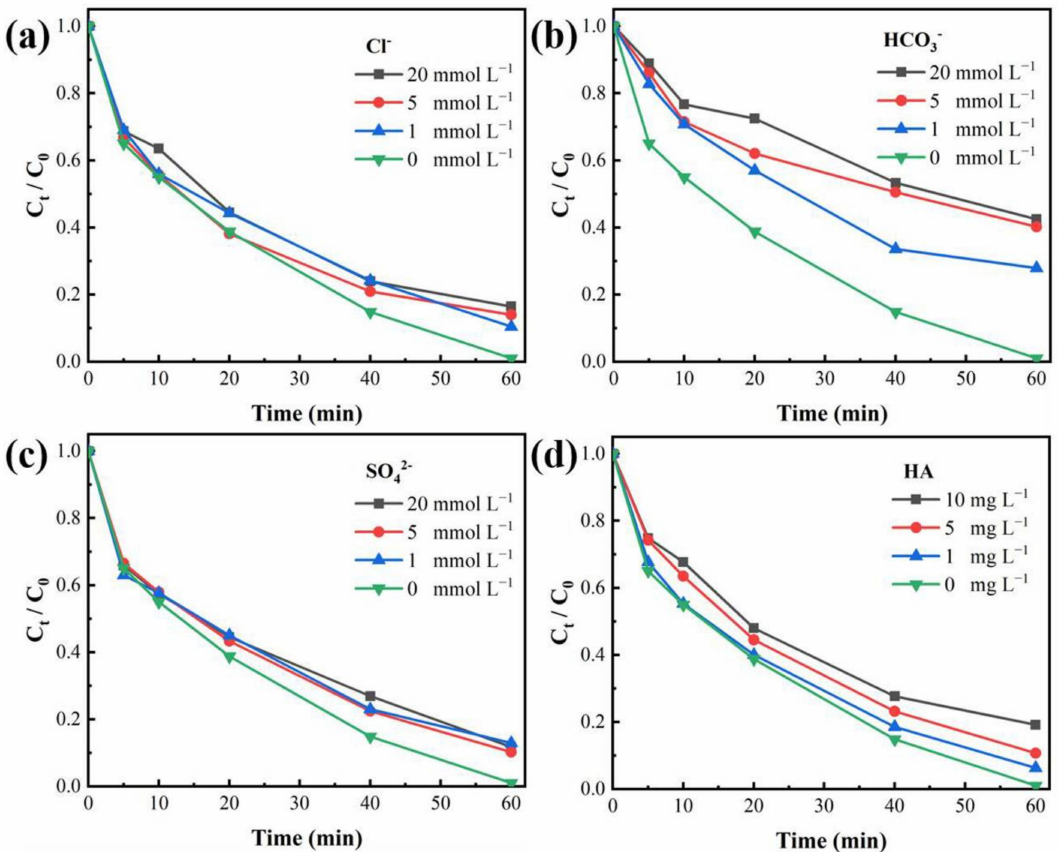
Figure 6. Effects of presence of ( a ) Cl − , ( b ) HCO 3 − , ( c ) SO 42 − , and ( d ) HA (0–10 mg L − 1 ) on MB decolorization in EC/Fe 2+ /PAA process. Experimental conditions: [MB] 0 = 20 mg L − 1 , [Fe 2+ ] 0 = 30 µ mol L − 1 , [PAA] 0 = 5.4 mmol L − 1 , [H 2 O 2 ] 0 = 11.25 mmol L − 1 , [NaNO 3 ] = 30 mmol L − 1 , pH = 2.9, j = 15 mA cm − 2